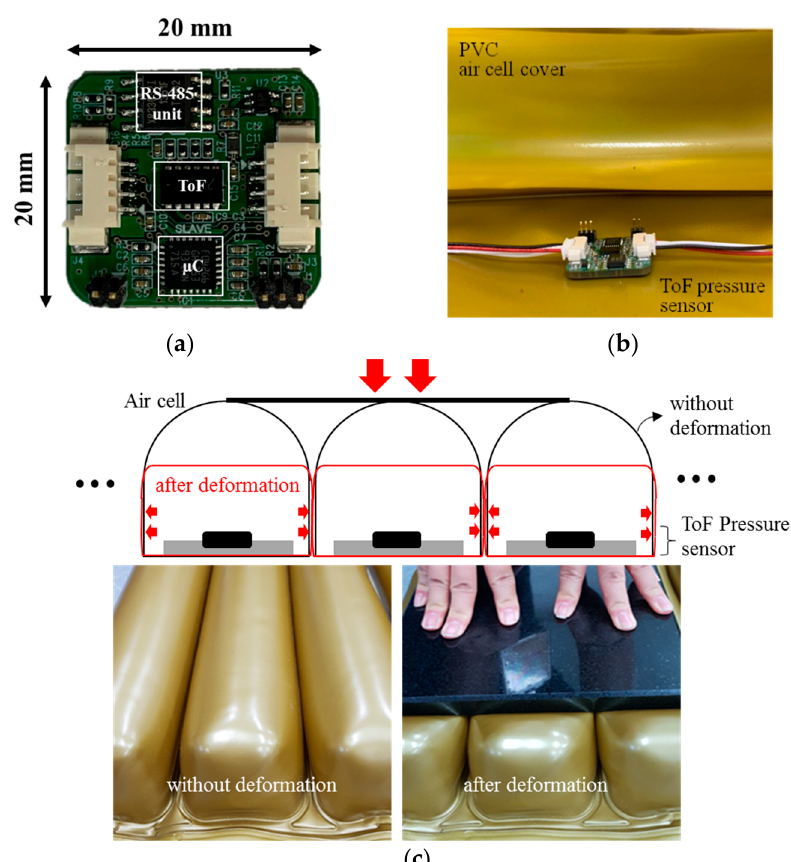
Figure 3. Pictures of ( a ) the developed ToF optical pressure sensor; ( b ) mounting the sensor inside of air-filled cell; ( c ) description of air-filled cell without and with deformation.